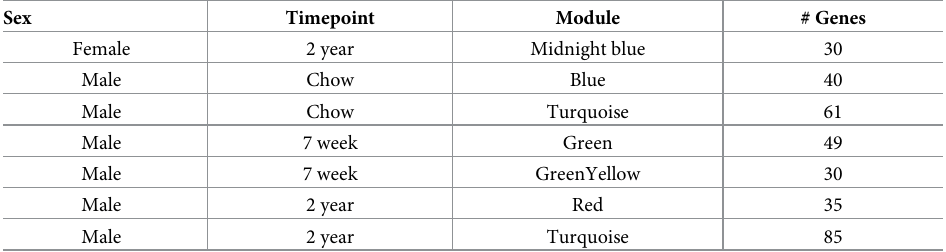
Table 6. Module genes with no GWAS variants, and not found in any significant pathways or networks. Sex Timepoint Module # Genes Female 2 year Midnight blue 30 Male Chow Blue 40 Male Chow Turquoise 61 Male 7 week Green 49 Male 7 week GreenYellow 30 Male 2 year Red 35 Male 2 year Turquoise 85 249 unique genes; 50 Genes in > 1